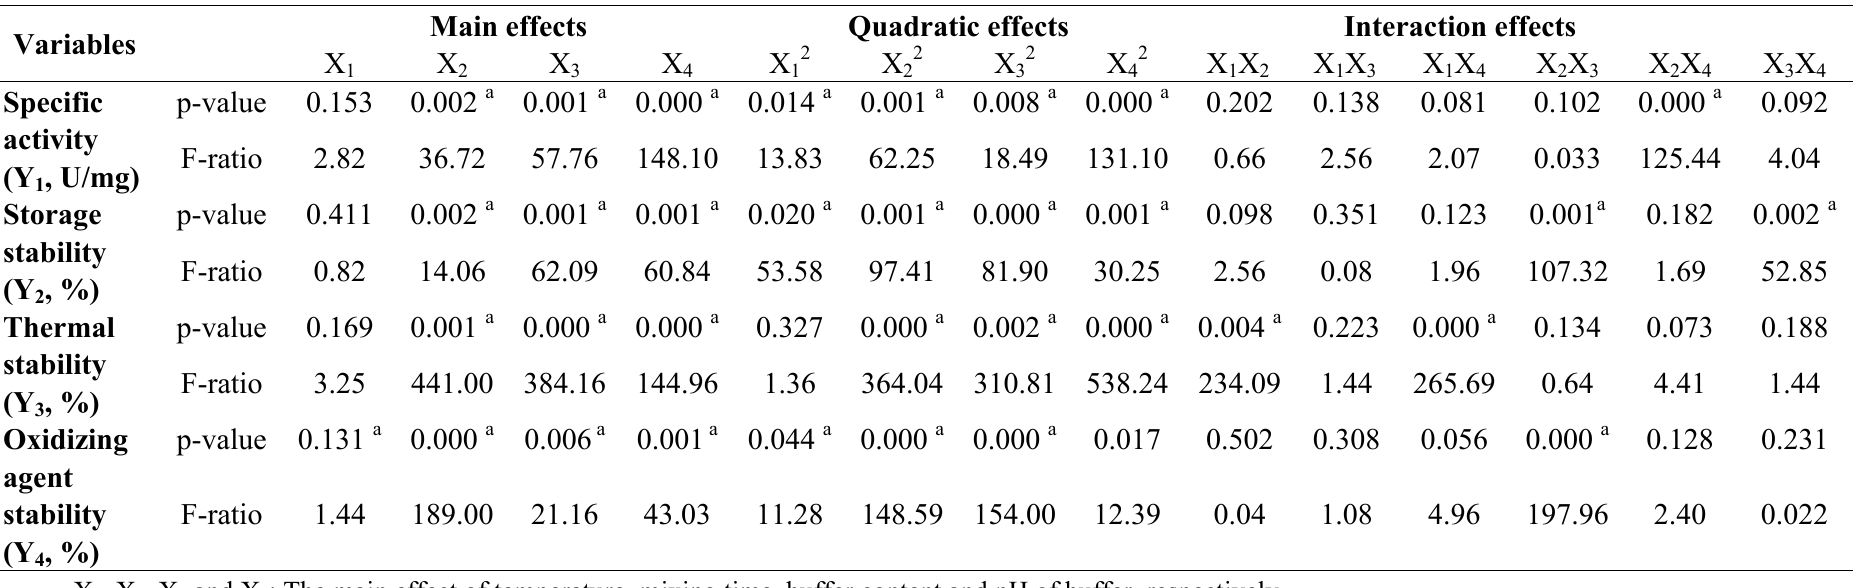
Table 4. F-ratio and p-value for each independent variable effect in the polynomial response surface